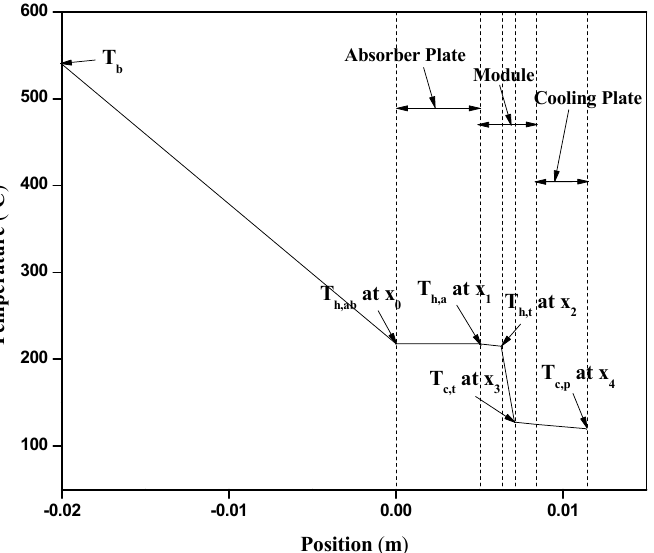
Figure 10. Temperature variation across a TEG system in the longitudinal direction of a billet obtained by numerical